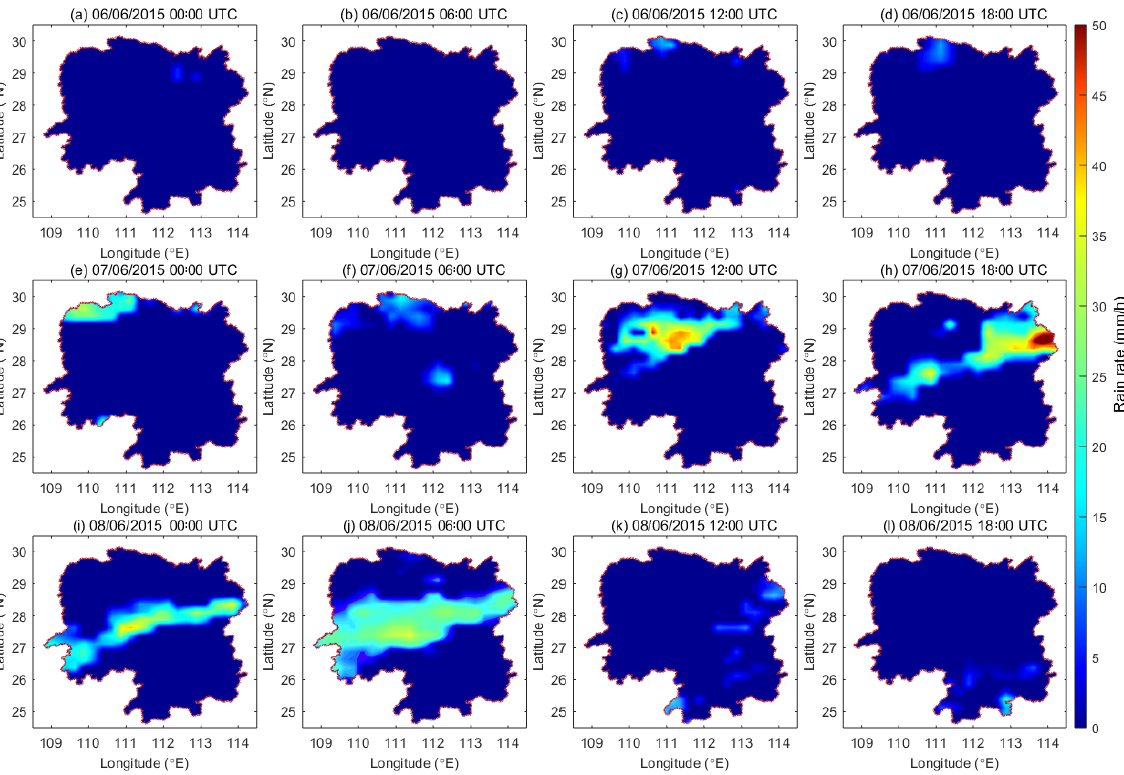
Figure 10. Evolution of rain rate maps for the Hunan Province every 6h from 00:00UTC, 6 June 2015, to 18:00UTC, 8 June 2015. The rain rate data were retrieved from the TRMM with a spatial resolution of 0 . 25 ◦ × 0 . 25 ◦ .